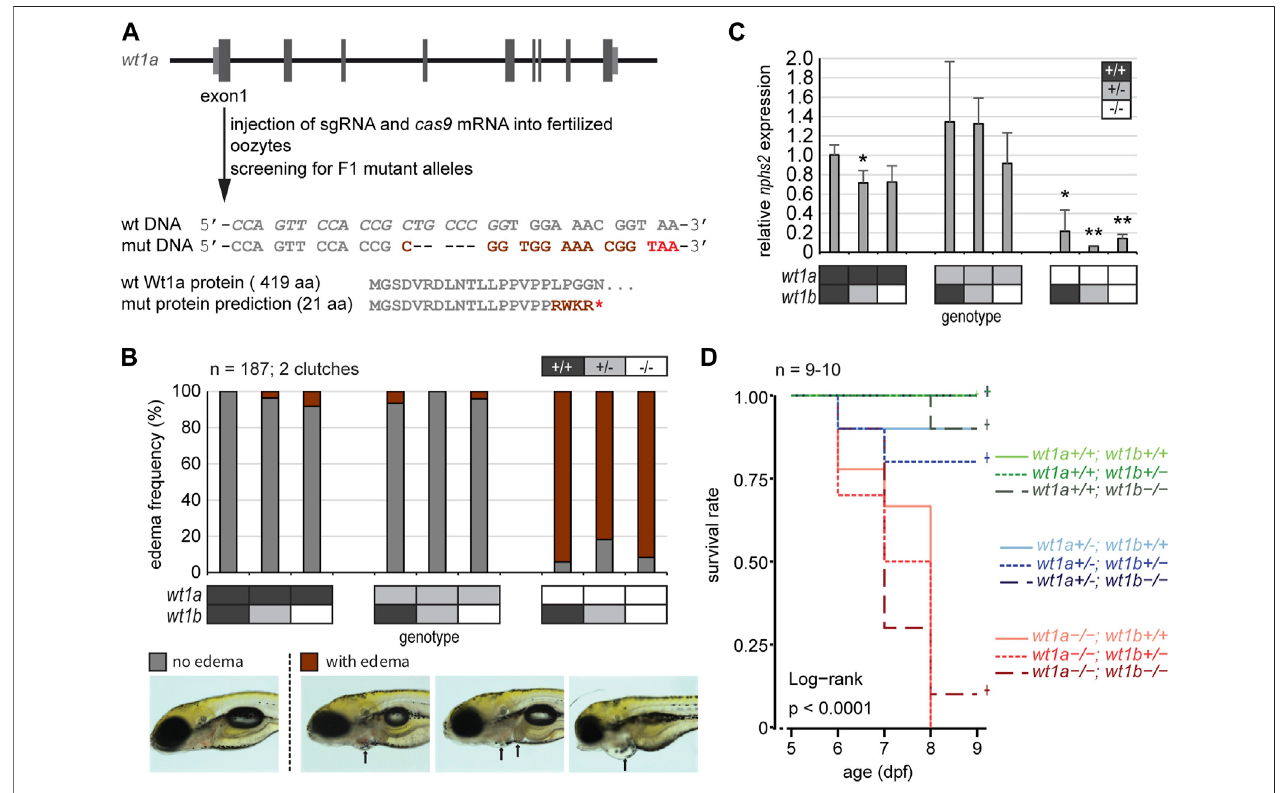
FIGURE 3 | Inactivation of wt1a results in edema formation and early lethality. (A) Schematic drawing of the wt1a gene locus and mutant generation. With the help of CRISPR/Cas, a fi sh line was established that lacks fi ve nucleotides in exon 1 of the wt1a gene ( wt1a ex1_del5 ). The sgRNA target sequence is italicized in the wild type DNA sequence. The 5 nt deletion is predicted to result in a frame shift (dark red) and a premature termination codon (red) that leads to a truncation of the protein. Abbreviations: wt (wild type); mut (mutant). (B) Offspring of a double heterozygous incross ( wt1a +/ - ; wt1b +/ - ) were screened for the formation of edema at fi ve dpf. The majority of wt1a − / − larvae have bodyedemas (arrows),independent ofthe wt1b ex2_del5 background.Examplepictures for noedema (grey), and bodyedemas (dark red) are shown; n (cid:1) 187. (C) qRT-PCR analysis of offspring of a double heterozygous incross ( wt1a +/ - ; wt1b +/ - ) indicates a strong reduction of nphs2 expression in wt1a − / − larvae.n (cid:1) 3(threeto fi velarvaeeach).Errorbarsrepresentstandarderror.One-wayANOVAwascalculatedas p (cid:1) 3.98*10 – 05 . p -valuesarecalculatedwitha t -testby pairwise comparison to wild type ( wt1a + / + ; wt1b + / + ). (D) Survival of offspring of a double heterozygous incross ( wt1a +/ - ; wt1b +/ - ) from fi ve to nine dpf shows an early onset of lethality of homozygous wt1a − / − larvae, independent of the wt1b ex2_del5 background. Survival is shown as a Kaplan-Meier curve. n (cid:1) 9 – 10 larvae per genotype.